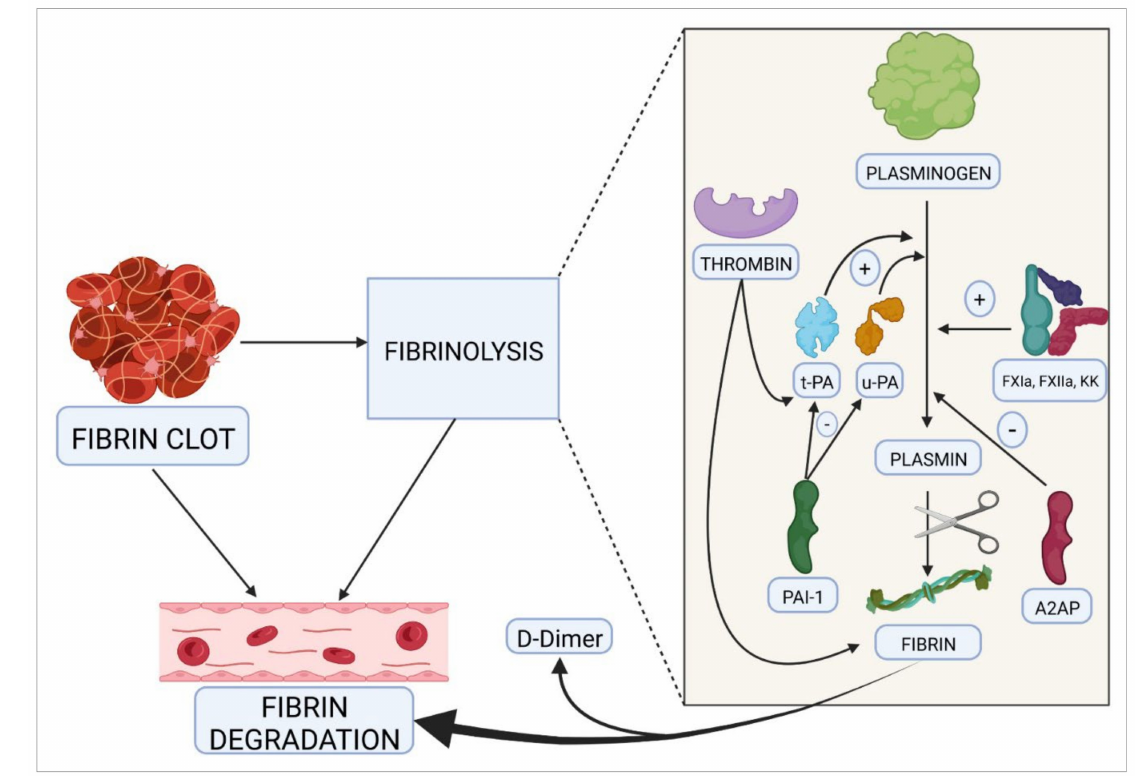
Figure 2. The fibrinolytic process. This pathway is modulated by proteases and clotting factors that stimulate the transformation of plasminogen into plasmin, which is in turn responsible for the subsequent degradation of fibrin. t-PA, tissue plasminogen activator; u-PA, urokinase; PAI-1, plasminogen activator inhibitor-1; A2AP, α 2-antiplasmin; FXIa, activated factor XI; FXIIa, activated factor XII; KK, kallikrein; (+), activation; (–),